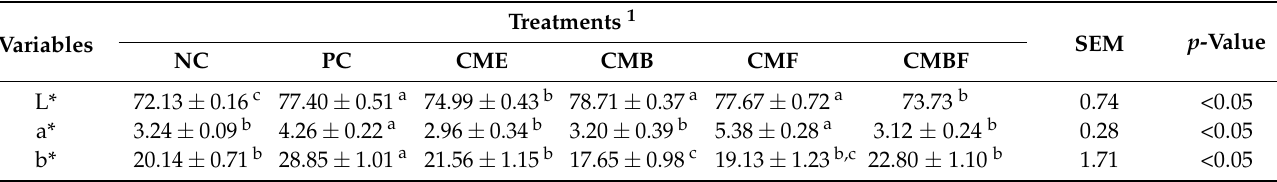
Table 3. The surface color of the breast meat of Korean ginseng chicken soup that was hydrolyzed with Cordyceps militaris mushroom